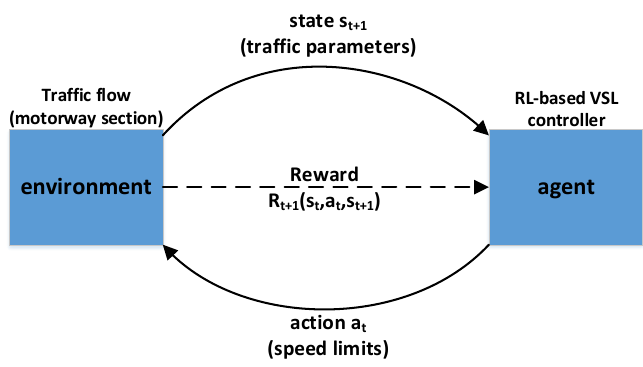
Figure 2. Reinforcement learning framework for VSL